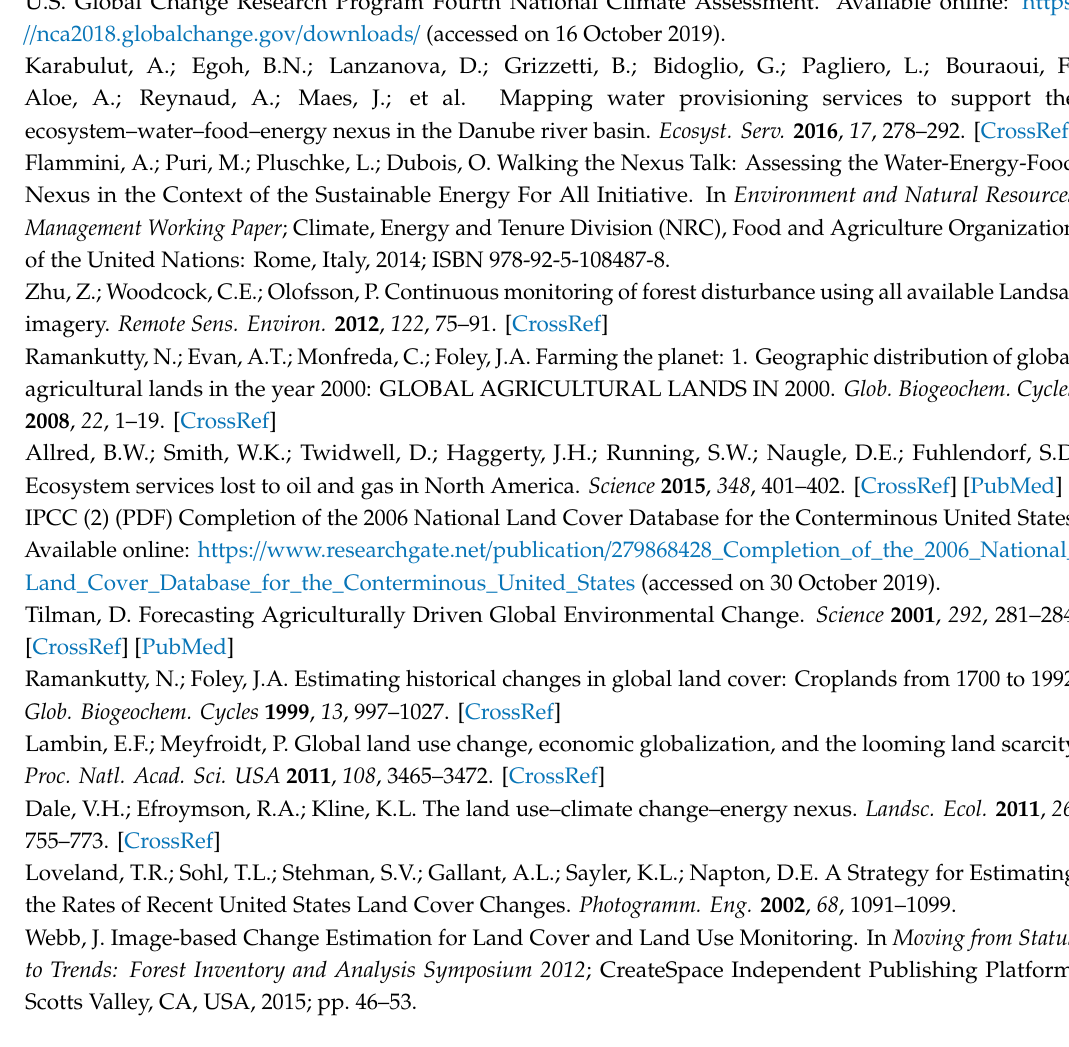
The description of the di ff erent columns and row is same as in Table